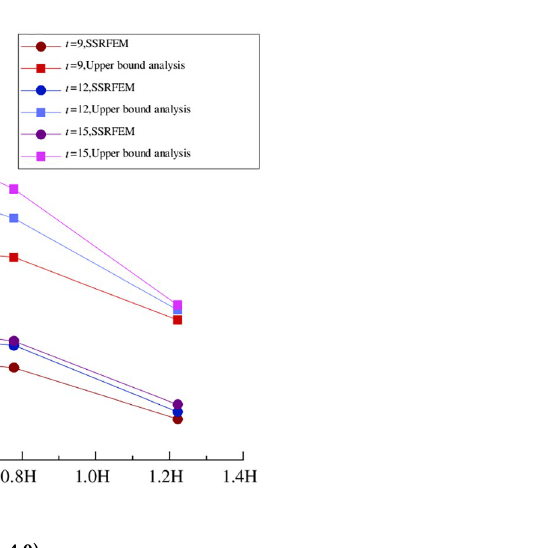
Fig 3. Relationships of N c with e and t ( H/B =